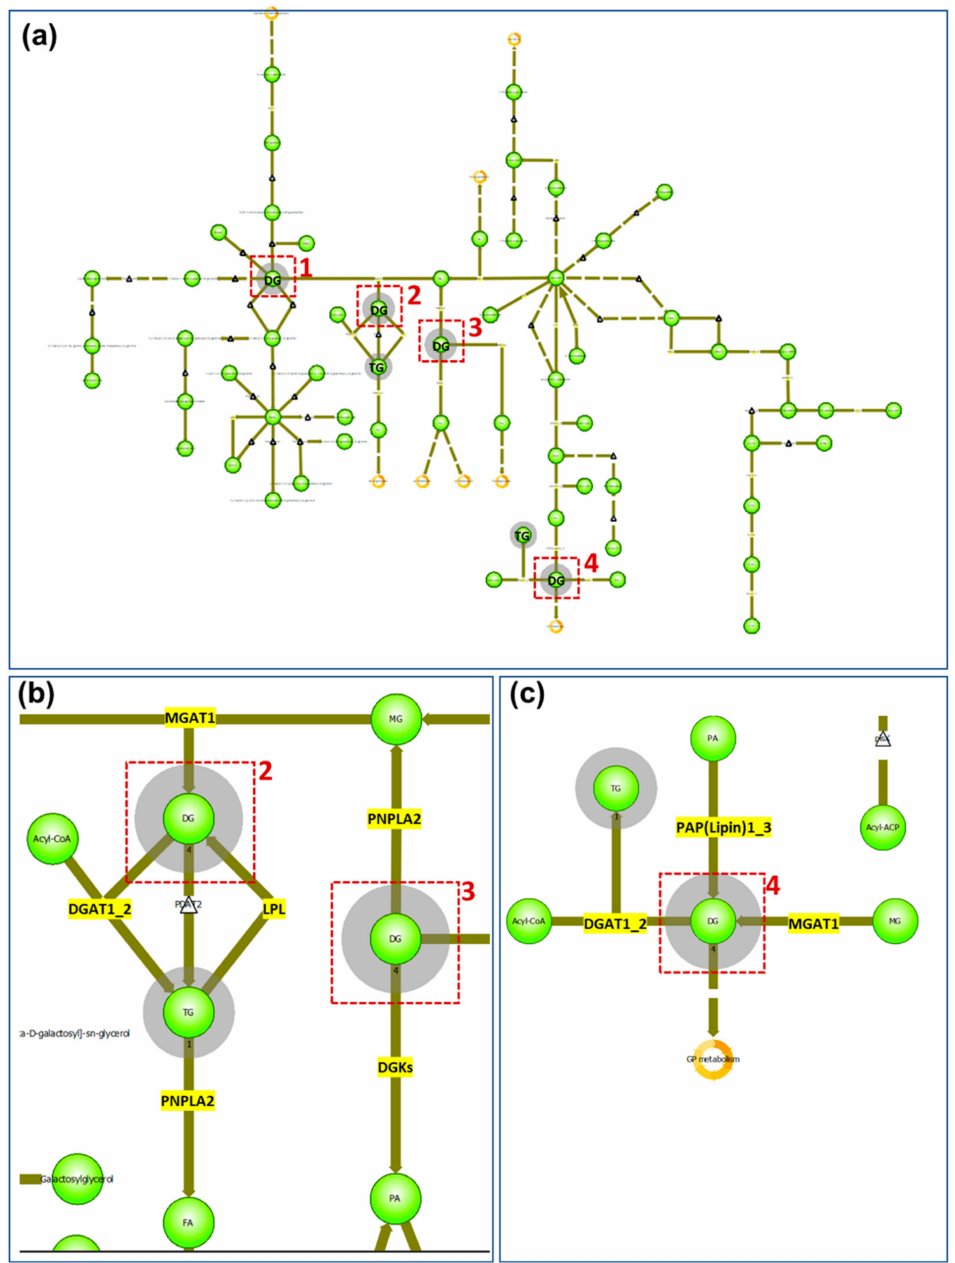
Figure 3. Glycerolipids pathway analysis of SG central zone markers: ( a ) global view of glycerolipids pathway. Red boxes indicate the nodes of DGs and the grey shadowed circles indicate the lipid classes detected from the imported list of compounds; ( b ) enlarged view of nodes 2 and 3 from ( a ). Enzymes existing in humans are highlighted in yellow; ( c ) enlarged view of node 4 from ( a ) with enzymes existing in humans highlighted in